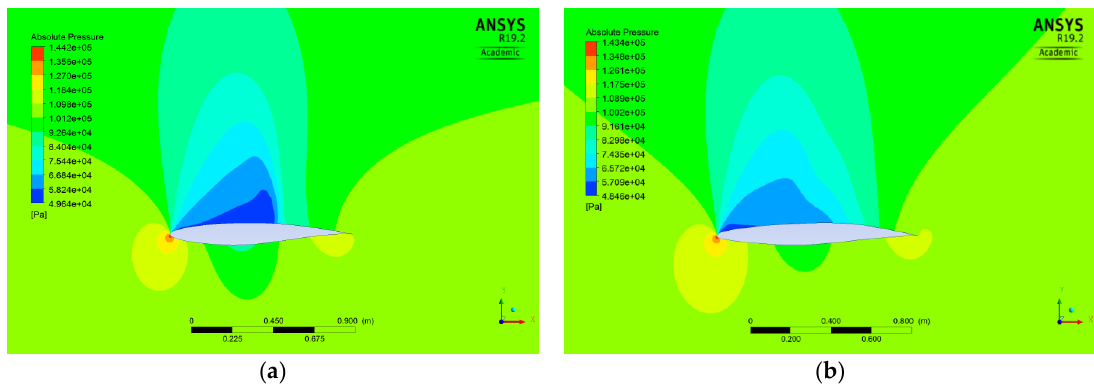
Figure 11. Absolute pressure distribution for the initial shape (RAE 2822) ( a ) and the optimal shape (at iteration 19) ( b ) for Test case II.